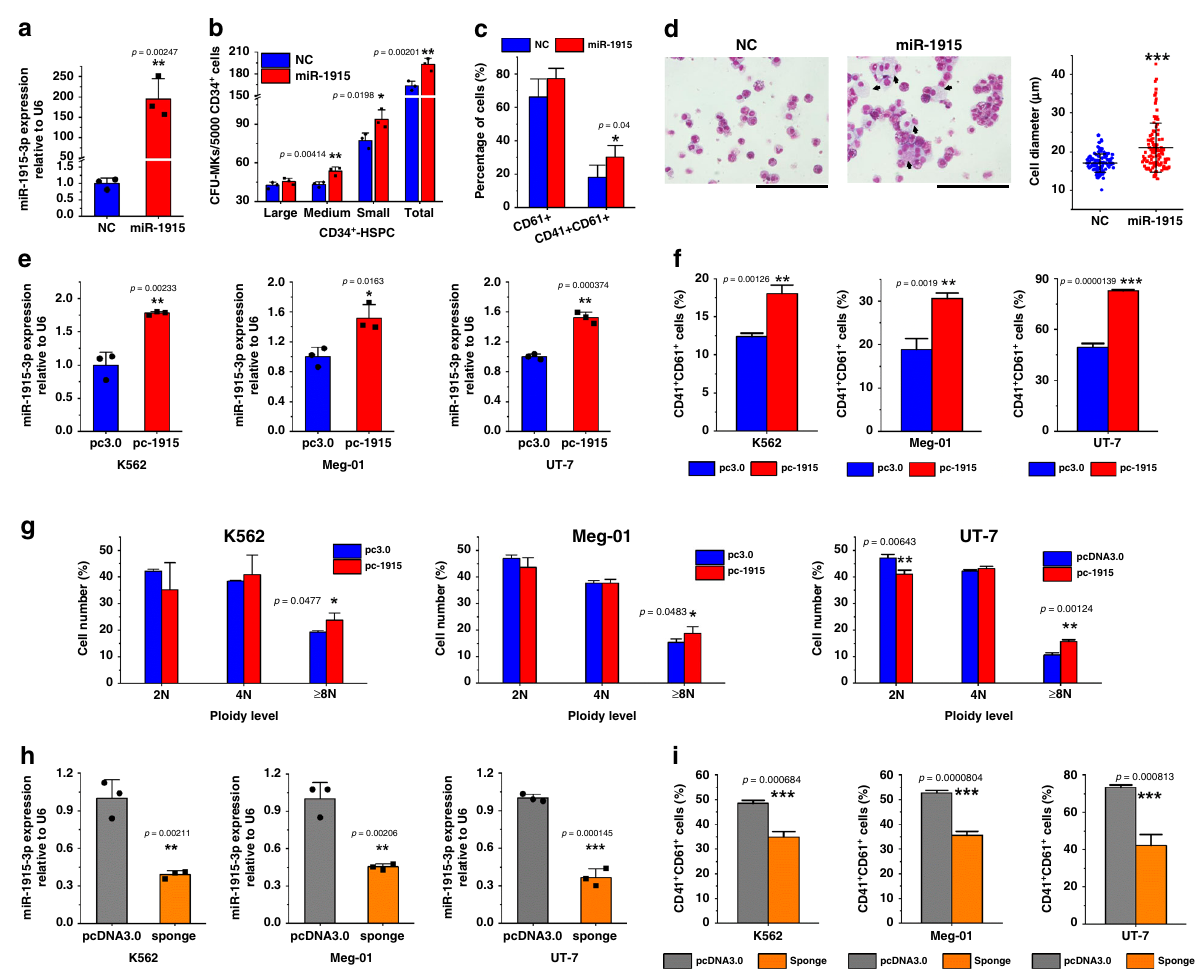
Fig. 4 Alteration of the miR-1915-3p expression affected MK differentiation and maturation. a qPCR con fi rmed the overexpression of miR-1915-3p in CD34 + -HSPCs after miRNA mimics (miR-1915) were transfected for 24 h compared with the negative control (NC). U6 was set as the normalized control ( n = 3 donors). b , c Overexpression of miR-1915-3p promoted the CFU-MKs from the CD34 + -HSPCs ( n = 3 donors, paired-samples t -tests) b and increased the expression of the MK integrins CD41 and CD61 on day 15. (mean ± S.E.M. of n = 5 donors, paired-samples t -tests) ( c ). Representative FCM plots are shown in Supplementary Fig. 6c. d By megakaryocytic induction on day 20, Cytospin and Wright – Giemsa staining demonstrated more polyploid cells and larger cell dimensions (black arrows) with miR-1915-3p overexpression. Cells from fi ve random views were measured. Statistical analysis and results were conducted on data from three biologically independent experimental replicates Unpaired t -tests with Welch ’ s correction were used for the statistical analysis. p < 0.0001. (Scale bars: 100 μ m) e – g In the K562, Meg-01 and UT-7 cells, overexpression of miR-1915-3p by stable transfection with a plasmid vector carrying primary miR-1915-3p ( n = 3 independent experiments) ( e ) promoted the CD41 + /CD61 + populations ( n = 3 independent experiments) ( f ) when cells were treated with a suboptimal amount of PMA for 3 days. Representative FCM plots are shown in Supplementary Fig. 7a. Cell polyploidization was upregulated with overexpression as well. g The percentage of cells of each ploidy is shown. Representative FCM histograms are shown in Supplementary Fig. 7b ( n = 3 independent experiments). h , i Suppression of miR-1915-3p expression with a miRNA sponge ( n = 3 independent experiments) h signi fi cantly decreased the CD41 + /CD61 + populations in the PMA-treated K562, UT-7 and Meg-01 cells i Representative FCM plots are shown in Supplementary Fig. 7d (n = 3 independent experiments). All data are shown as the mean ± S.D from two-tailed unpaired-samples t -tests. P -value unless otherwise speci fi ed. Source data are provided as a Source Data fi le * P < 0.05, ** P < 0.01, *** P <